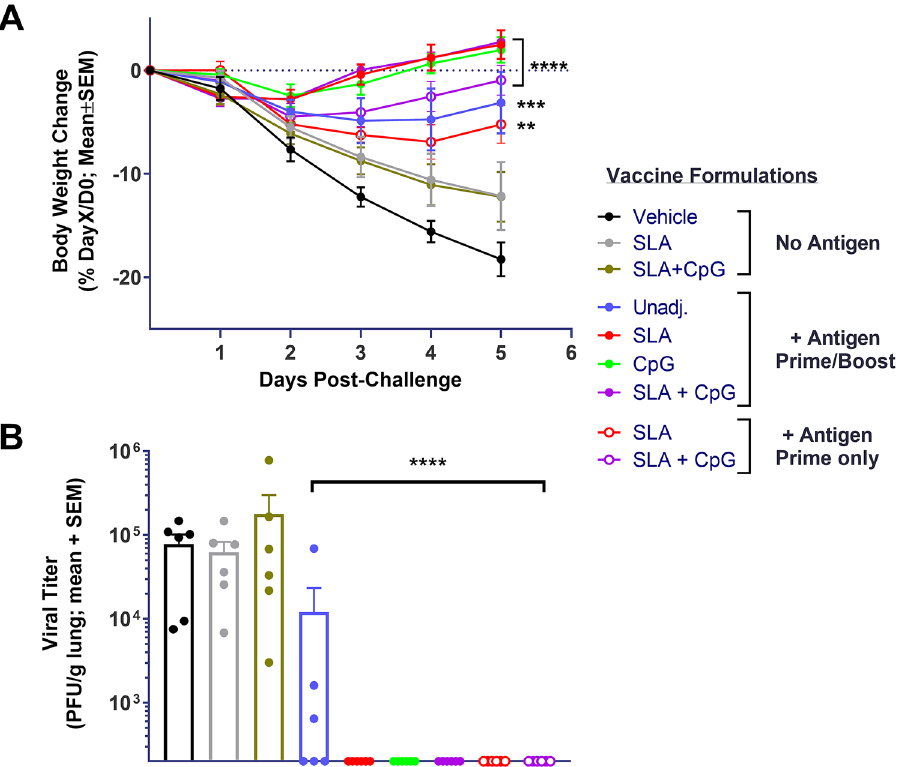
Figure 6. Efficacy of SmT1-based vaccine formulations adjuvanted with SLA, CpG or SLA + CpG in hamster challenge model. Syrian Golden hamsters (n = 6/group) were immunized i.m. with 3 µg of SmT1 alone or with SLA and alone or in combination on Days 0 ± 21. As negative controls, hamsters received either vehicle or adjuvant alone. On Day 35, hamsters were challenged intranasally with 1 × 10 5 PFU of SARS-CoV-2 ( A ). On Day 5, lungs were collected and viral load measured by plaque assay ( B ). Grouped data is presented as mean + standard error of mean. Statistical significance of differences for the groups vs. the vehicle control group is shown: **p < 0.01, ***p < 0.001 and ****p < 0.0001 by two-way ( A ) or one-way ( B ) ANOVA followed by Tukey’s multiple comparisons